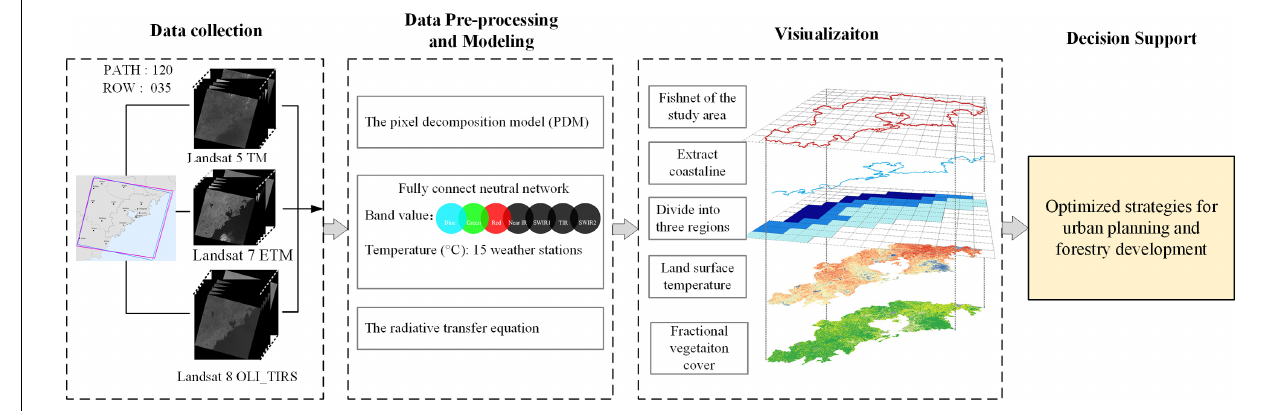
FIGURE 1 | Research procedure of applying Digital